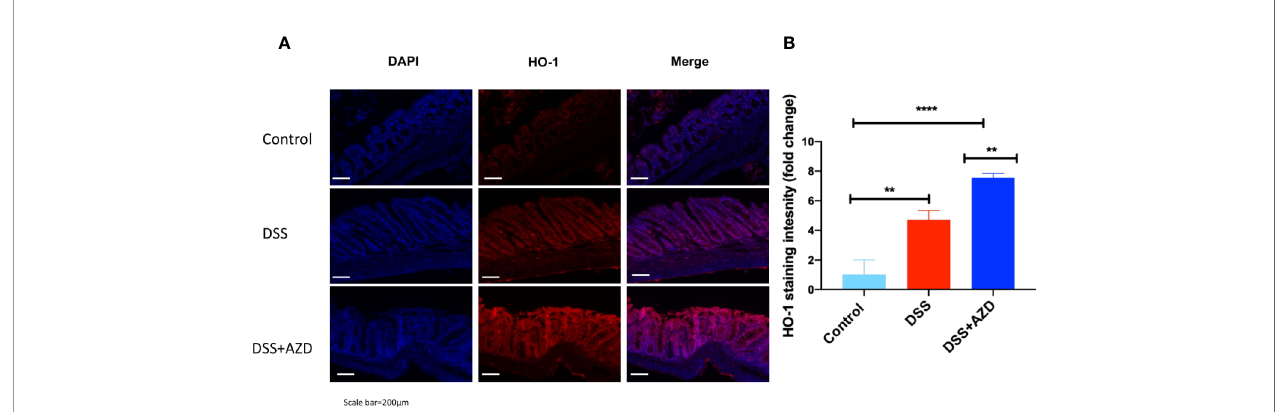
FIGURE 9 | Representative HO-1 immuno fl uorescence images of colon sections challenged with dextran sodium sulfate (DSS) for 9 days in the absence or presence of AZD3241 supplementation. Mice were randomly divided into three treatment arms over 9 days i) vehicle group (n = 5) given normal drinking water and peanut butter without drug; ii) DSS group (n = 5) given 2% w/v DSS in drinking water and peanut butter without drug; iii) DSS+AZD3241 (n = 5) given 2% w/v DSS in drinking water and AZD3241 @ 30 mg/kg in peanut butter. (A) Colons were resected after 9 days of treatment, embedded in paraf fi n and sectioned for immuno fl uorescence studies as described in the methodology section. Representative qualitative images were taken from at least three fi elds of view from each colon at 20x magni fi cation on a multi fi lter fl uorescent microscope (ZEISS AXIOscope; Talavera Rd, Sydney, Australia). (B) Total fl uorescent intensity was averaged across each series of images and presented fold change. Only three animals per group were imaged for these experiments. **p = 0.001, ****p <